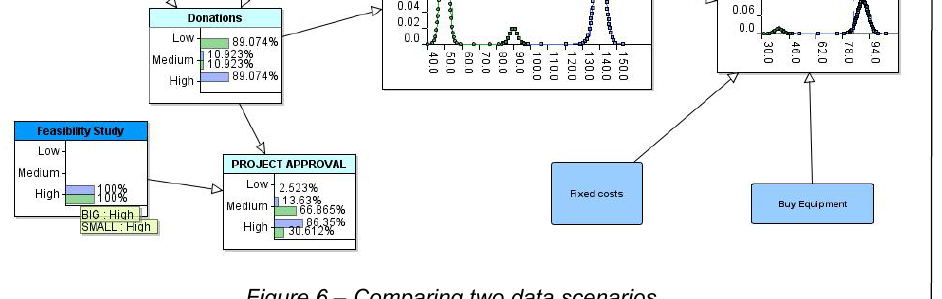
Figure 6 – Comparing two data scenarios Рис . 6 – Сравнение двух